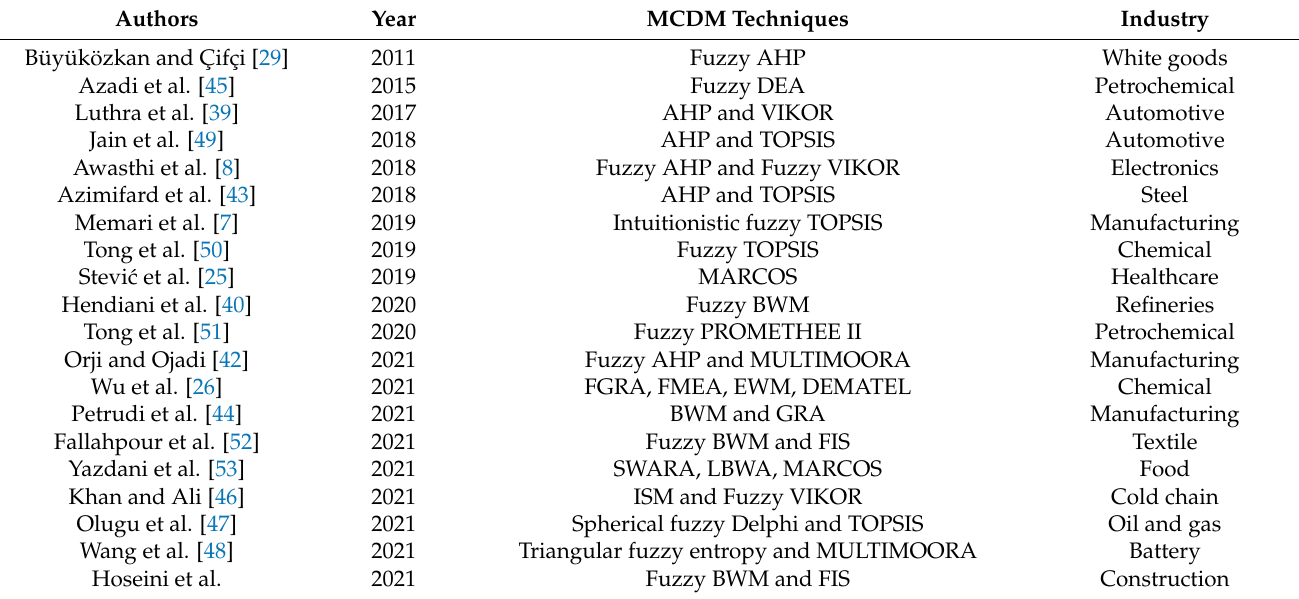
Table 2. A brief literature review summary of MCDM methods for